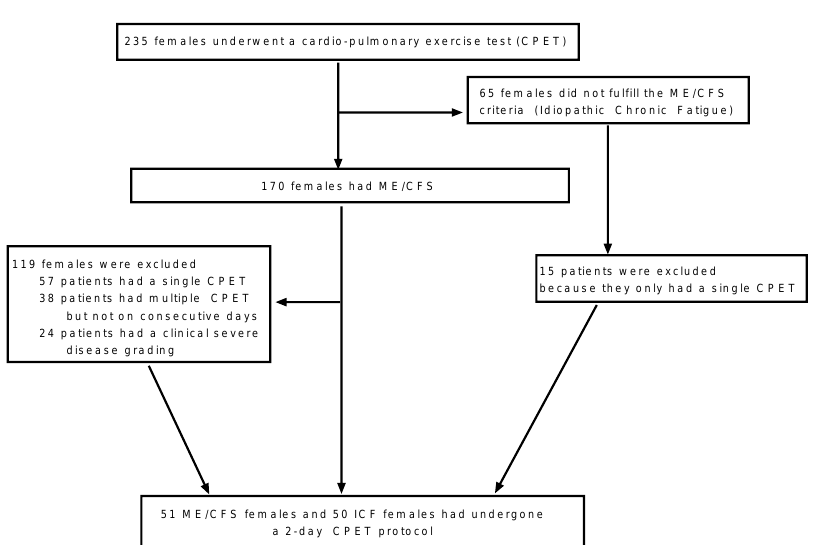
Figure A1. Patient flow. CPET: cardiopulmonary exercise test; ME/CFS: myalgic encephalomyeli- tis/chronic fatigue syndrome; ICF: idiopathic chronic